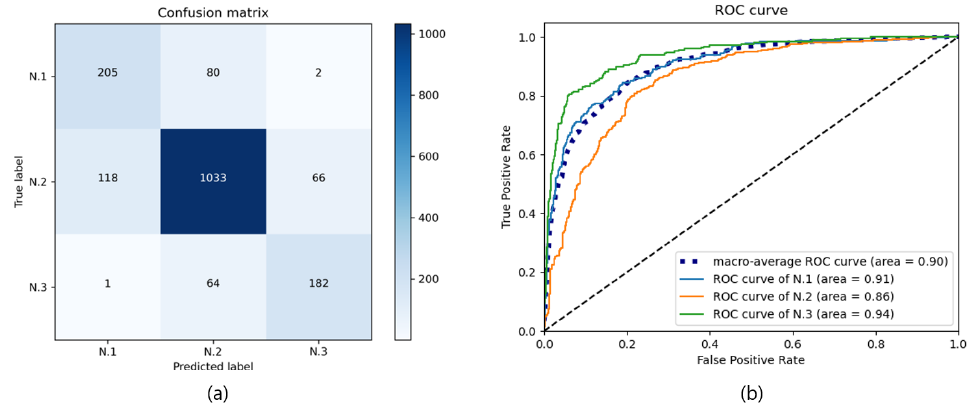
Figure 8. ( a ) The confusion matrix for the likelihood of IAN injury classification, ( b ) the ROC curve for the likelihood of IAN injury